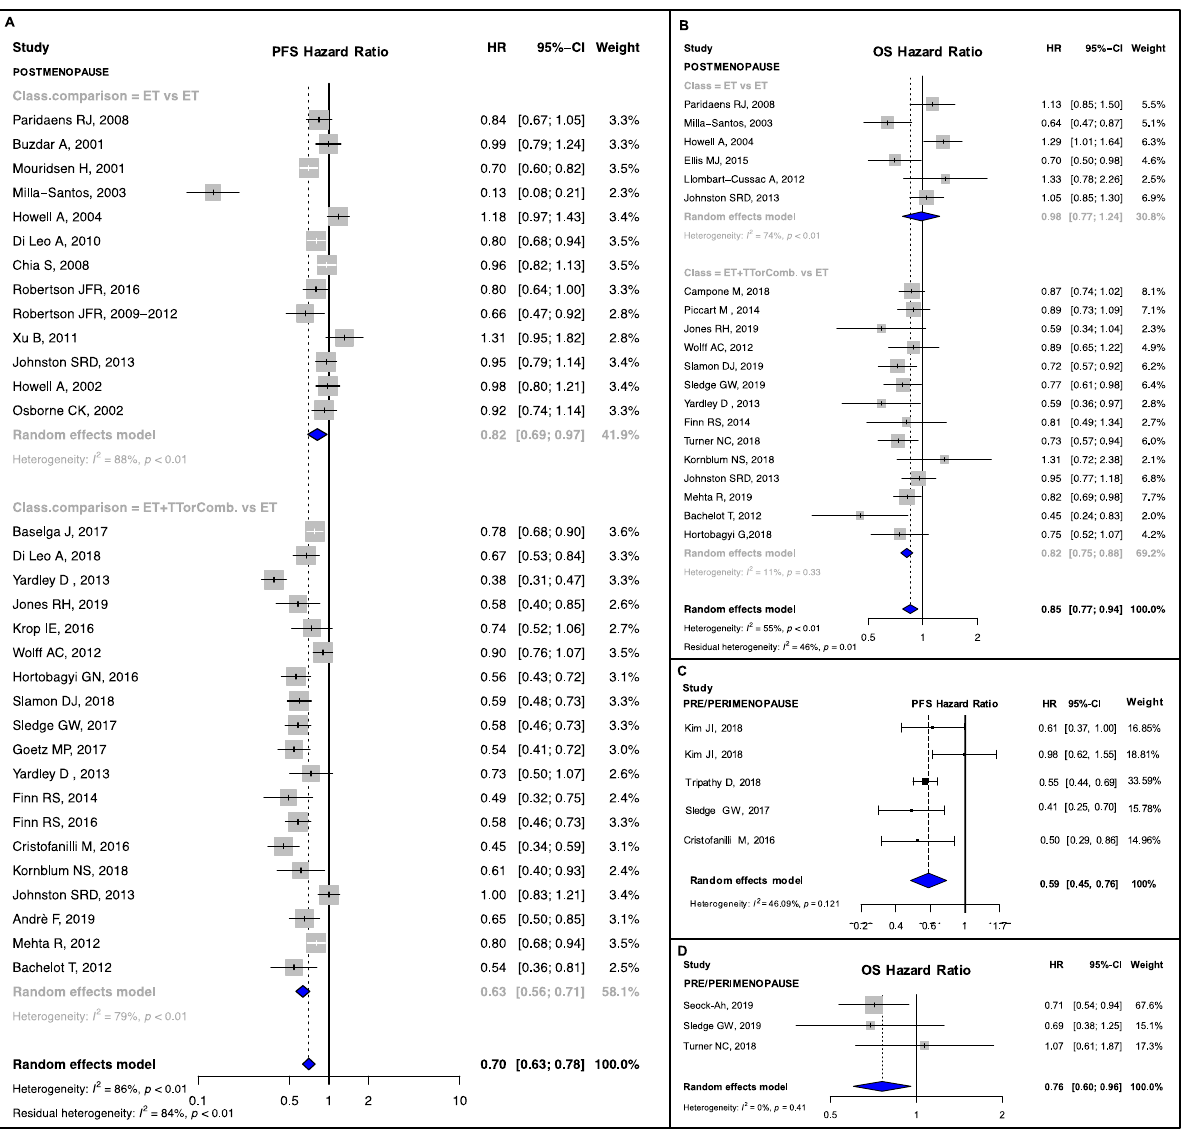
Figure 2. PFS and OS pooled results according to menopausal status: PFS ( A ) and OS ( B ) pooled result for the postmenopausal subgroup, overall and according to treatment strategy; and PFS ( C ) and OS ( D ) pooled result for the pre/perimenopausal subgroup. PFS, progression-free survival; OS, overall survival; ET vs. ET, studies comparing single endocrine agents therapies; ET + TTorComb. vs. ET, studies comparing endocrine therapies + target therapies or endocrine therapies combinations against single agent endocrine treatments; HR, hazard ratio; 95% CI, 95% confidence